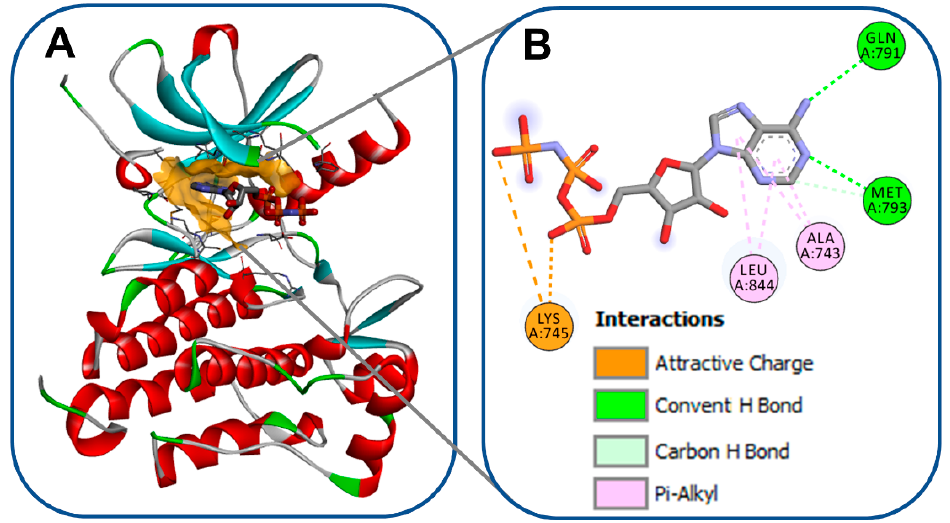
Figure 2. Wild-type EGFR bound to AMPPNP (pdb: 3VJO): ( A ) 3D binding mode of AMPPNP, receptor shown as hydrogen bond surface; ( B ) 2D binding mode showing different types of interactions; the figure was generated using BIOVIA Discovery Studio Visualizer (V16.1.0.15350).